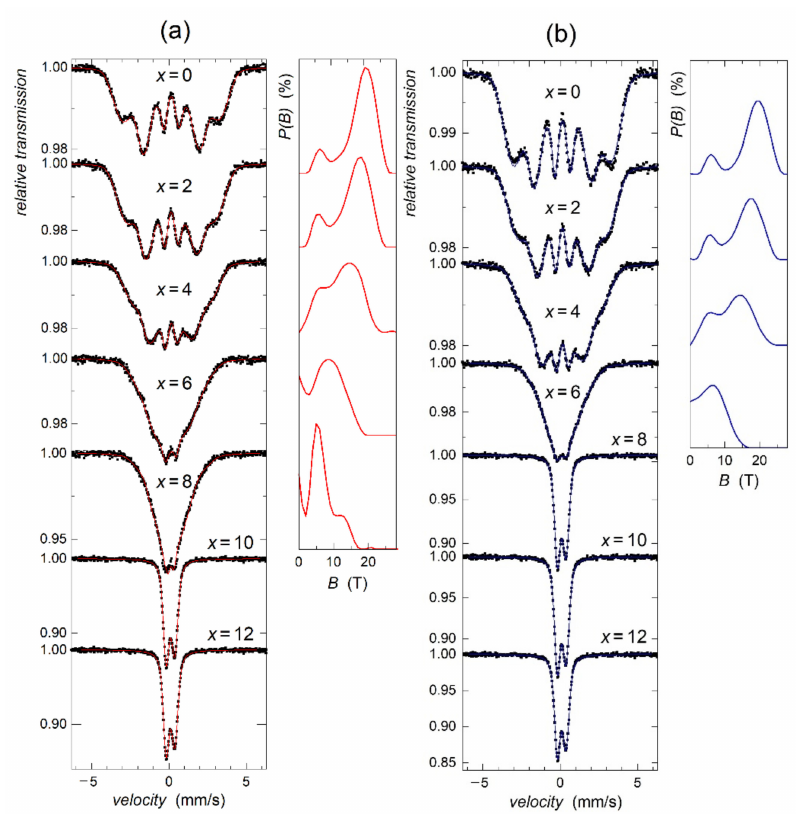
Figure 6. Mössbauer spectra and corresponding P ( B ) distributions of the Fe 30 Ni 48- x Cr x Mo 2 Si 5 B 15 for the indicated chromium contents, x : ( a ) In non-irradiated state; ( b ) after neutron irradiation with a fluence of 10 19 n/cm 2